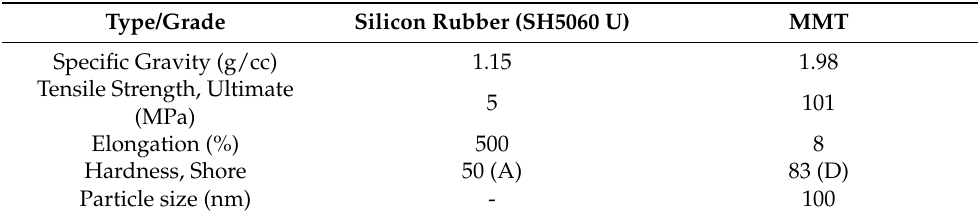
Table 1. Properties of Material.